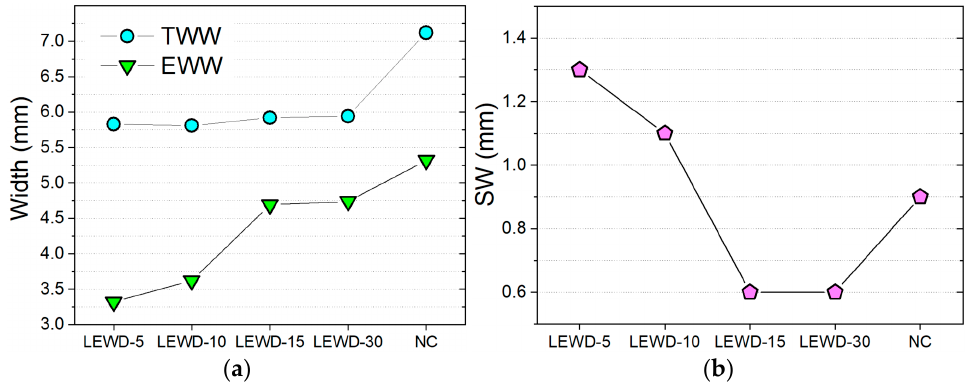
Figure 6. Quantitative effect of the LEWD parameter on the geometrical quality of the 350 mm-long walls: ( a ) effect of LEWD on the total and effective wall width and ( b ) on surface waviness.